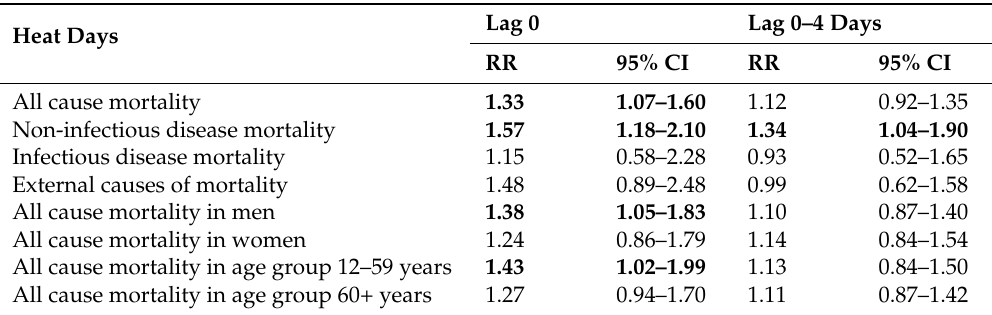
Table A2. Association of heat and cold with mortality stratified by cause, age, and sex Vadu HDSS, 2003–2012 (relative risks with 95% confidence